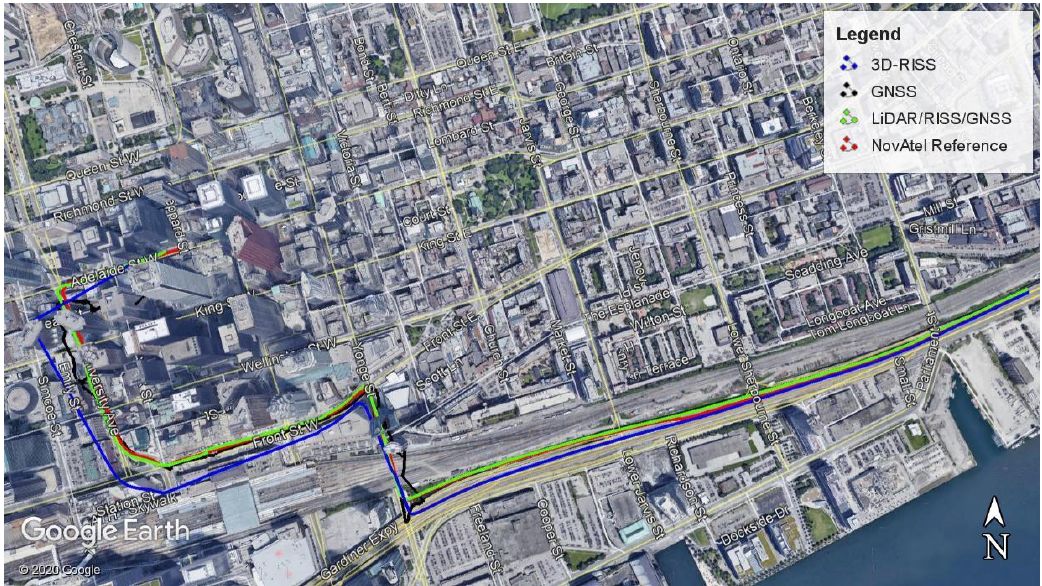
Figure 20. Navigation Solution for 3D-RISS, GNSS, LiDAR / RISS / GNSS, and NovAtel Reference During the Selected Scenario.